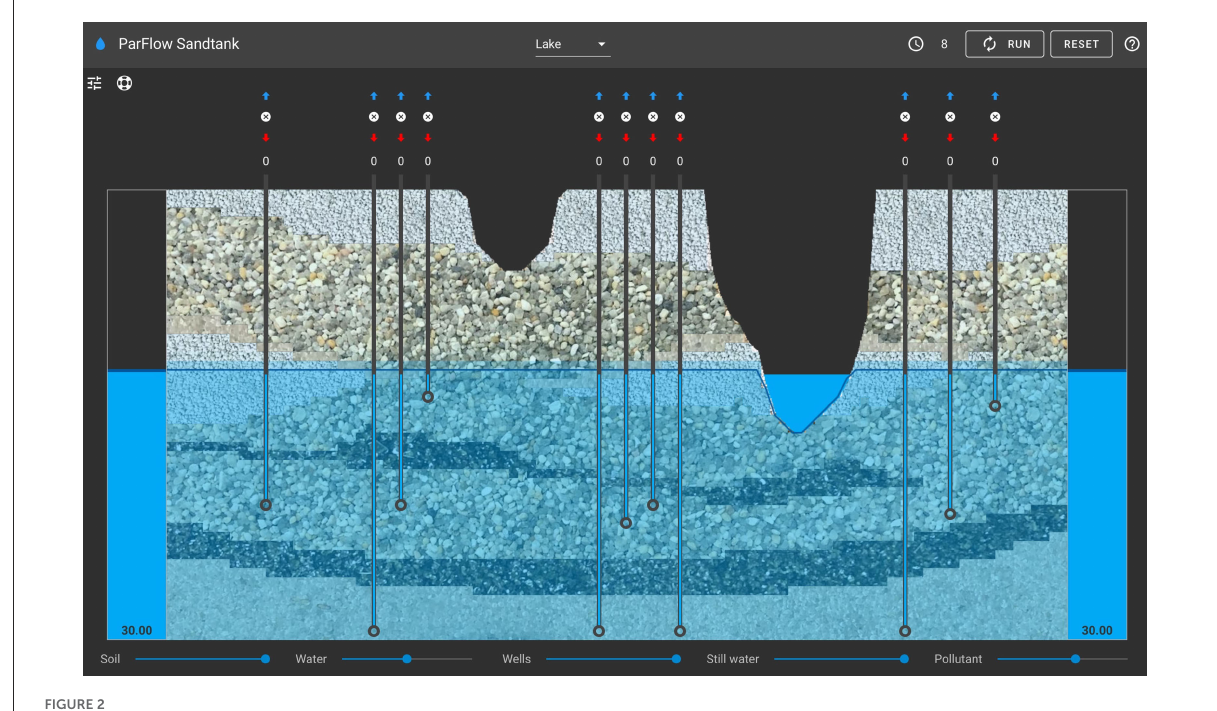
FIGURE2 The ParFlow Sandtank model